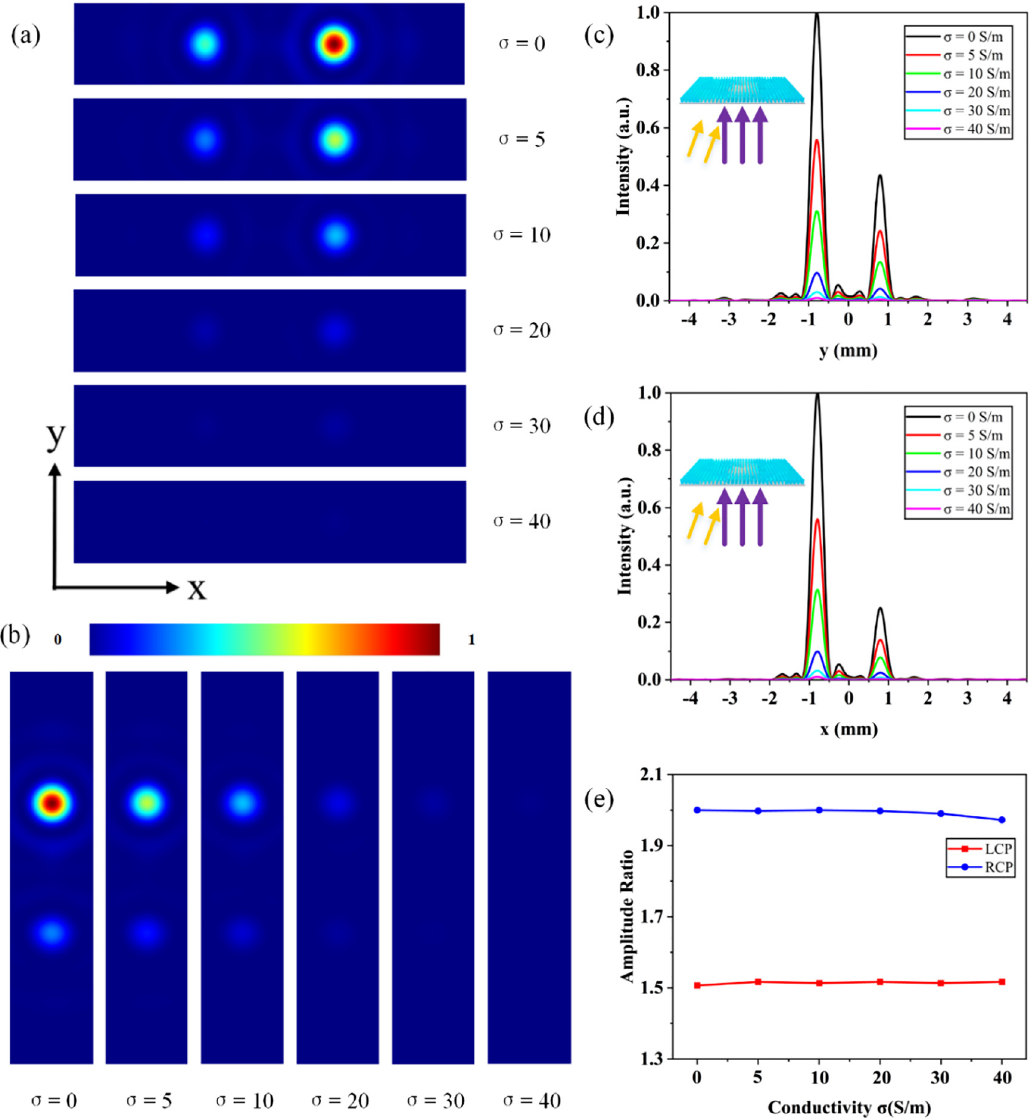
Figure 6: The dynamic behavior induced by optical pumping. Thesimulatedintensityprofilesastheconductivityofsiliconincreasesunderthe(a)LCP(b)RCPillumination.(c)Theintensityprofilealongthe x axisat thefocal planeas theconductivity of siliconincreasesundertheLCP illumination.(d) Theintensity pro fi le alongthe y axisat thefocal plane as the conductivity of silicon increases under the RCP illumination. (e) The amplitude ratios of the generated two foci along the x / y axis as the conductivity of silicon